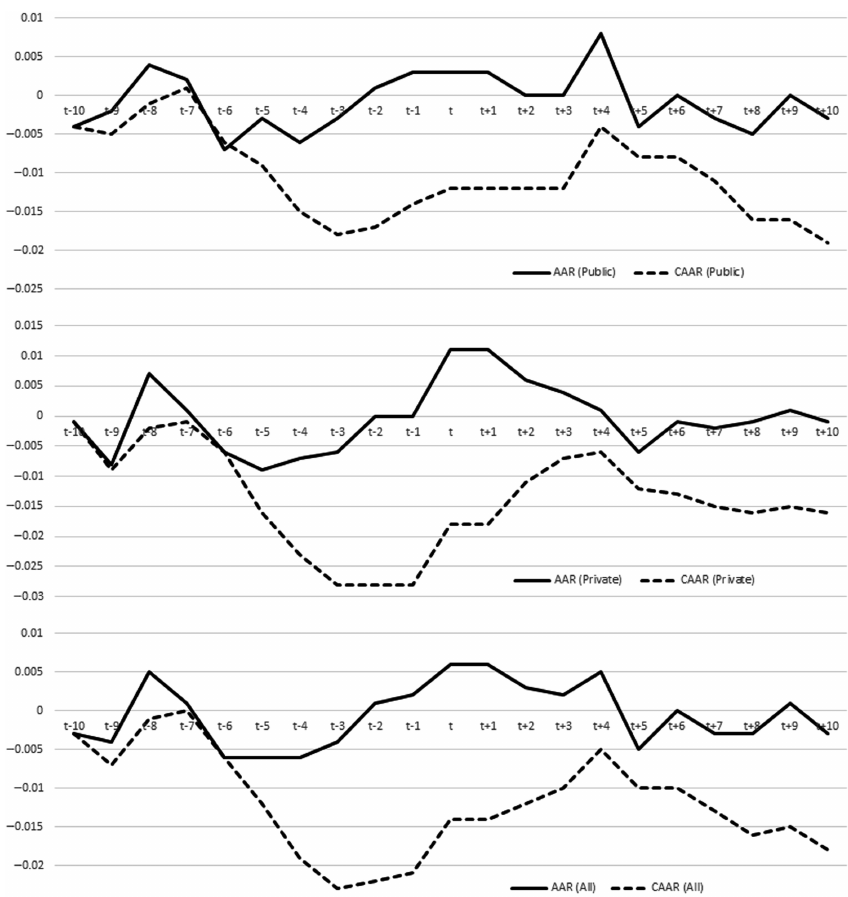
Figure 2. AAR and